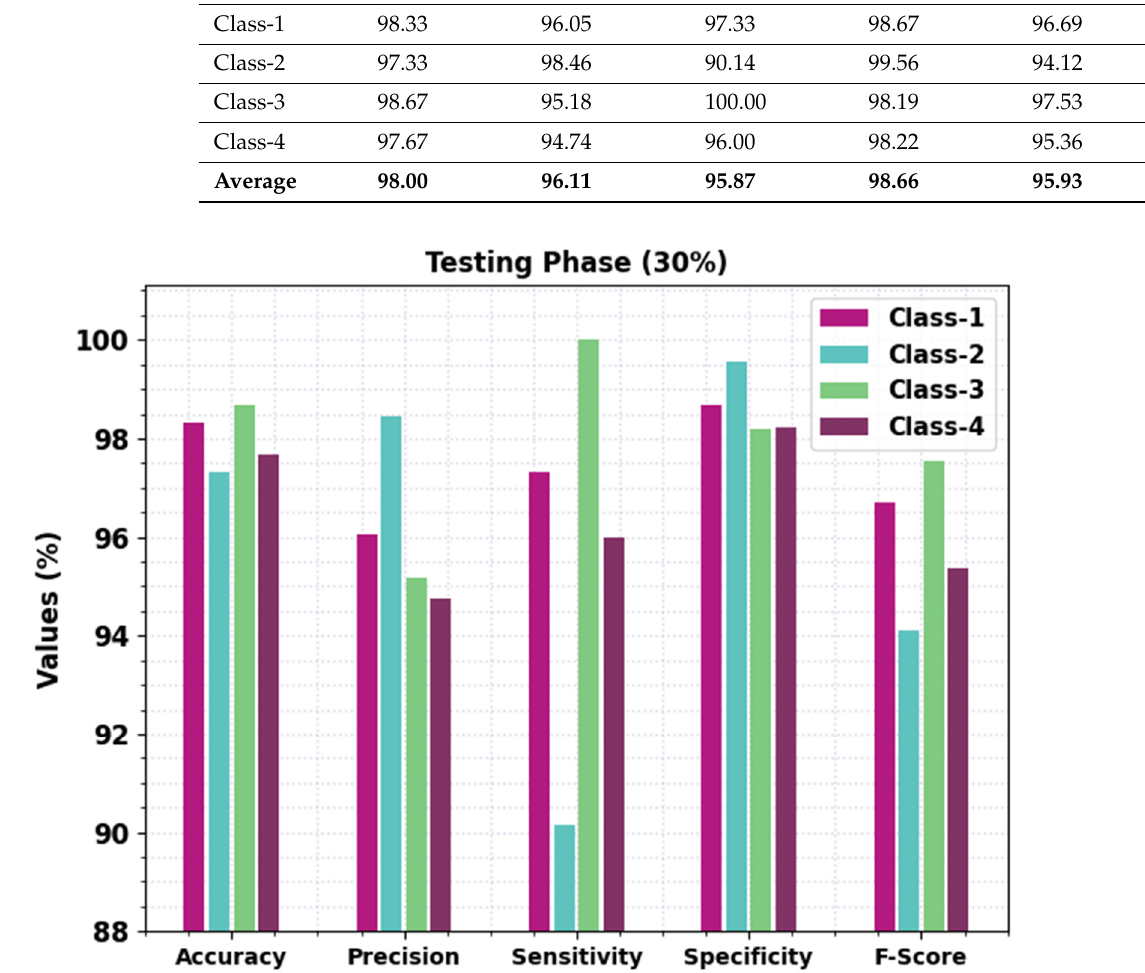
Figure 6. Crowd classification outcome of the AOTL-CDA3S system under 30% of the TS